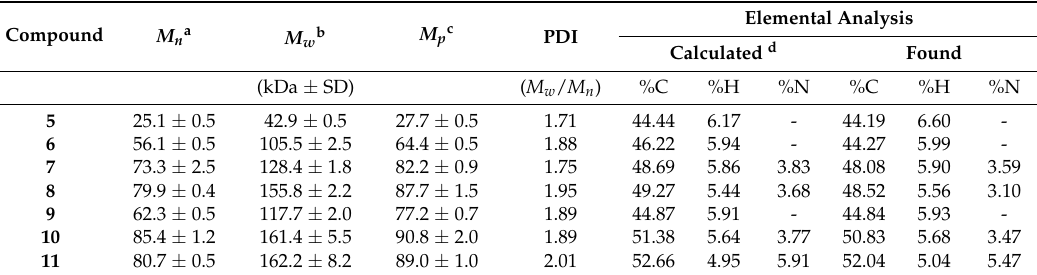
Table 1. Average molecular weights and the polydispersity index (PDI) determined by Size Exclusion Chromatography (SEC) and elemental analysis of dextran 5 , carboxylated dextran derivatives 6 and 9 , and TSPO ligand conjugates 7 , 8 , 10 and 11